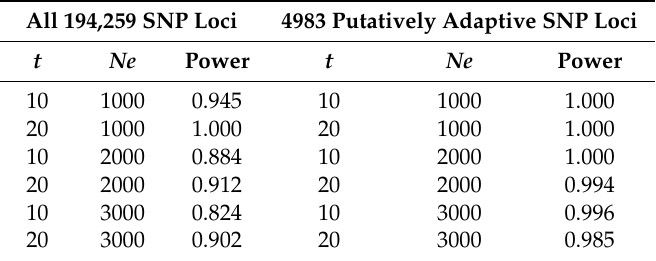
Table 4. Results of the power analysis conducted on all 194,259 SNP loci and 4983 putatively adaptive SNP